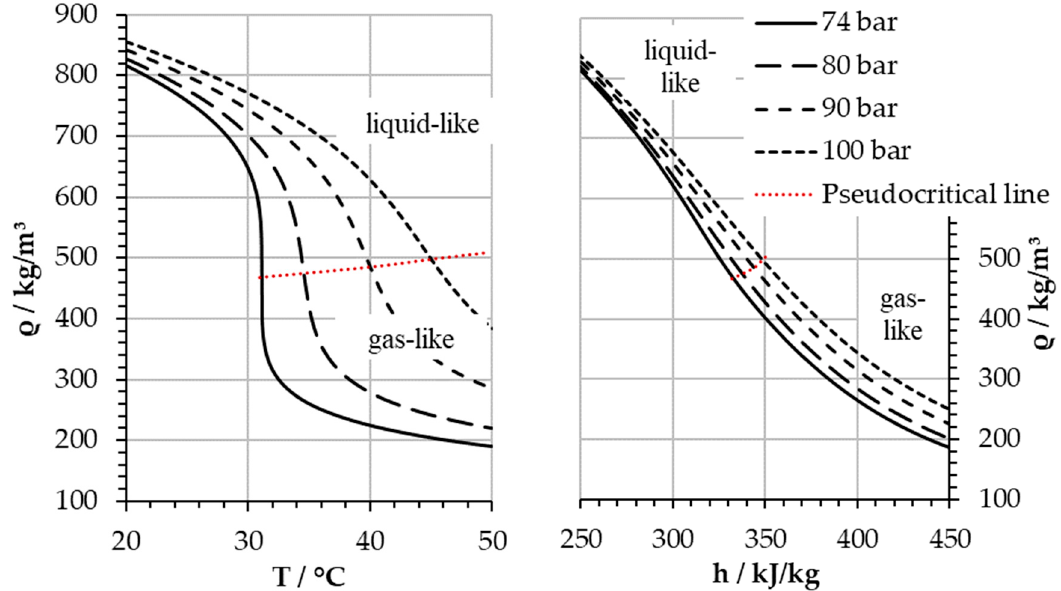
Figure 6. sCO2-properties—density as function of static temperature ( left ) and enthalpy ( right ).